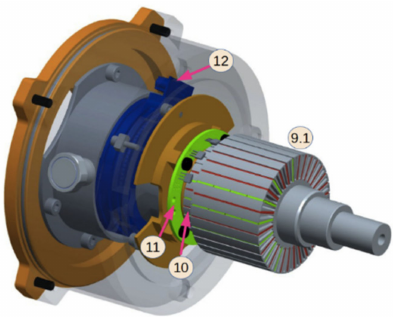
Figure 11. Sensor concept and the main motor rotor.